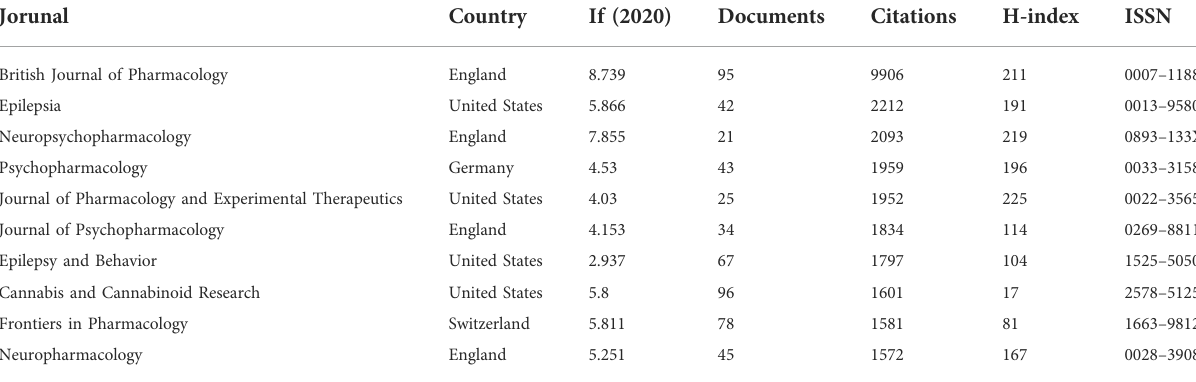
TABLE 3 The top 10 most-cited journals in the cannabidiol fi